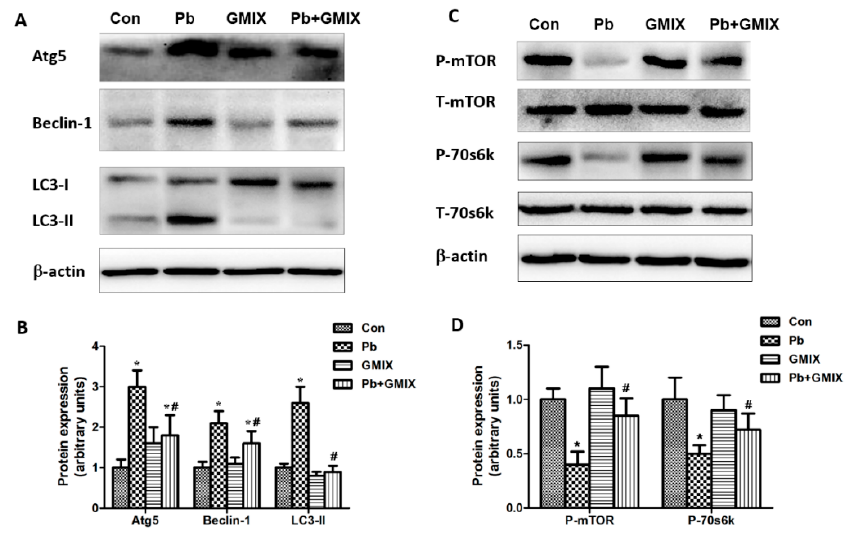
Figure 5. Effect of GMIX on the expression of autophagic related proteins and mTOR pathways in HT22 cells. ( A ) Protein expression of Atg5, Beclin-1 and LC3 in HT22 cells; ( B ) the values from densitometry of Atg5, Beclin-1 and LC3-II are normalized to the level of β -actin protein and expressed as fold increase; ( C ) rhe phosphorylation of mTOR and p70s6k; ( D ) the values from the densitometry of phosphorylated mTOR/p70s6k are normalized to the level of total mTOR/p70s6k. The data are expressed as means ± SD of three independent experiments. * p < 0.05 vs. control group; # p < 0.05 vs. Pb group.